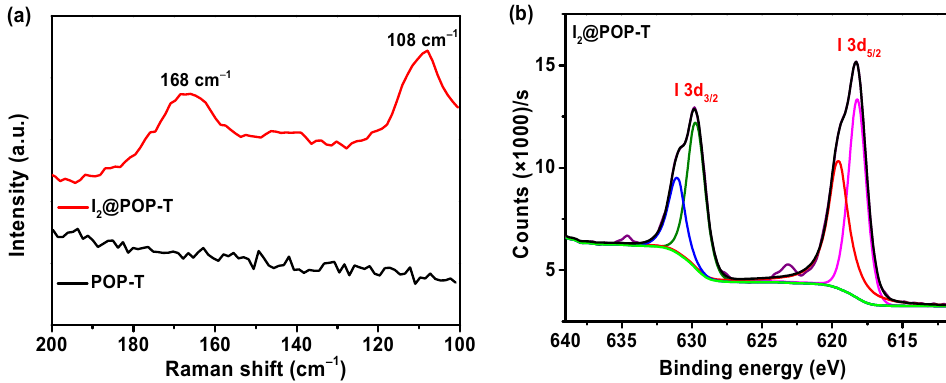
Figure 4. ( a ) Raman spectra of POP-T and I 2 @POP-T and ( b ) XPS spectrum of I 2 @POP-T.